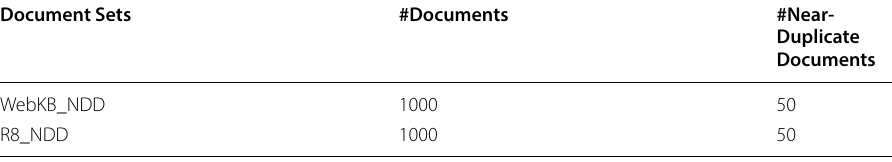
Table 6 Properties of document sets used in near-duplicates detection experiment Document